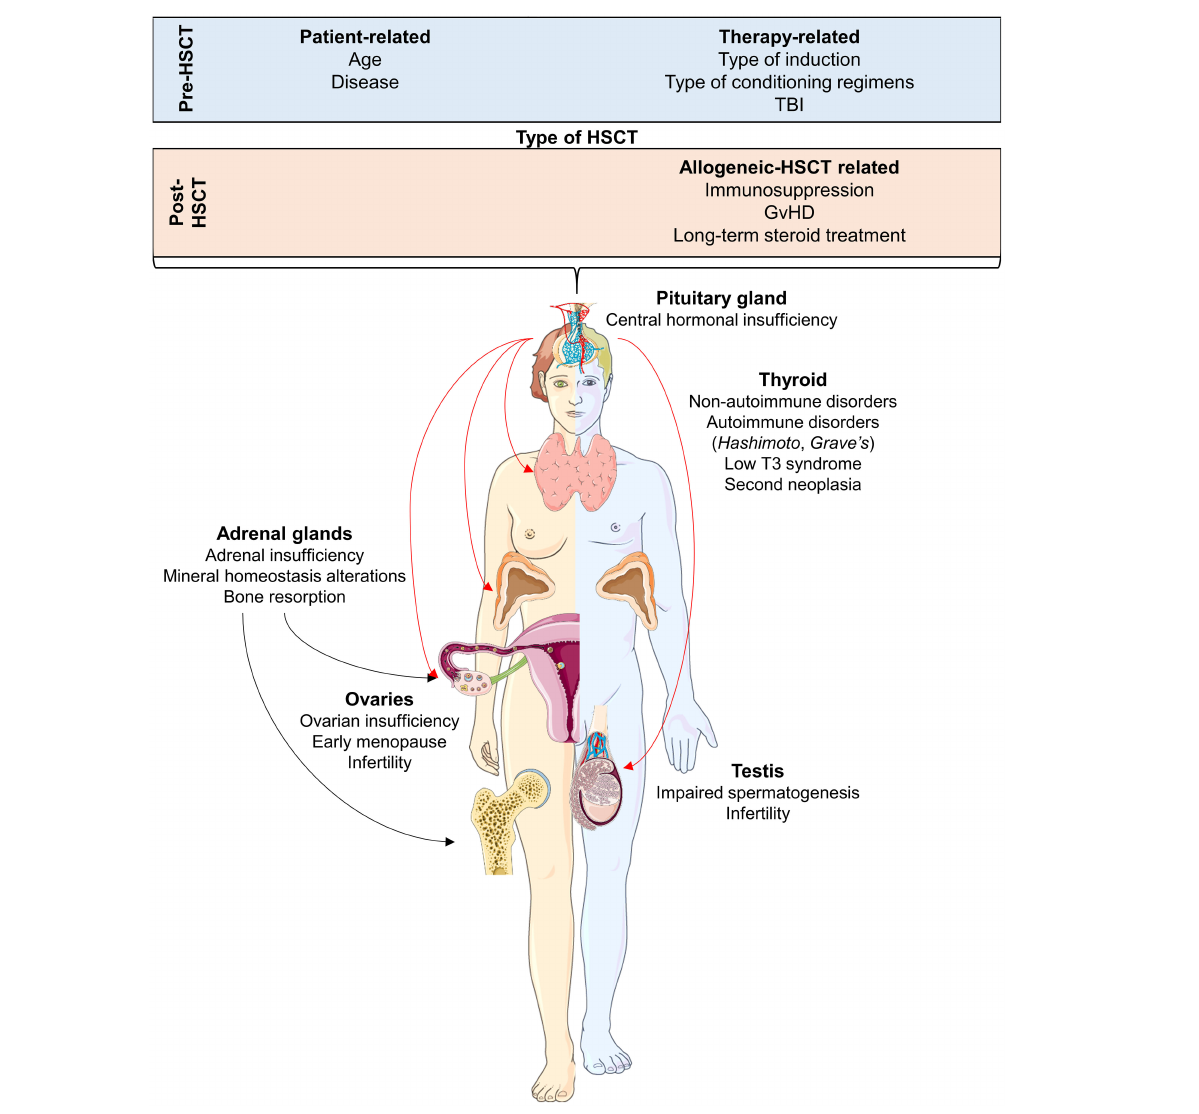
FIGURE 1 Endocrine complications after hematopoietic stem cell transplantation (HSCT) for each organ and tissue affected. Pre- and post-transplant conditions that are considered as risk factors of endocrine sequelae are also displayed. Abbreviations. TBI, total body irradiation; GvHD, Graft versus Host DIsease. Parts of the fi gure were drawn by using pictures from Servier Medical Art. Servier Medical Art by Servier is licensed under a Creative Commons Attribution 3.0 Unported License